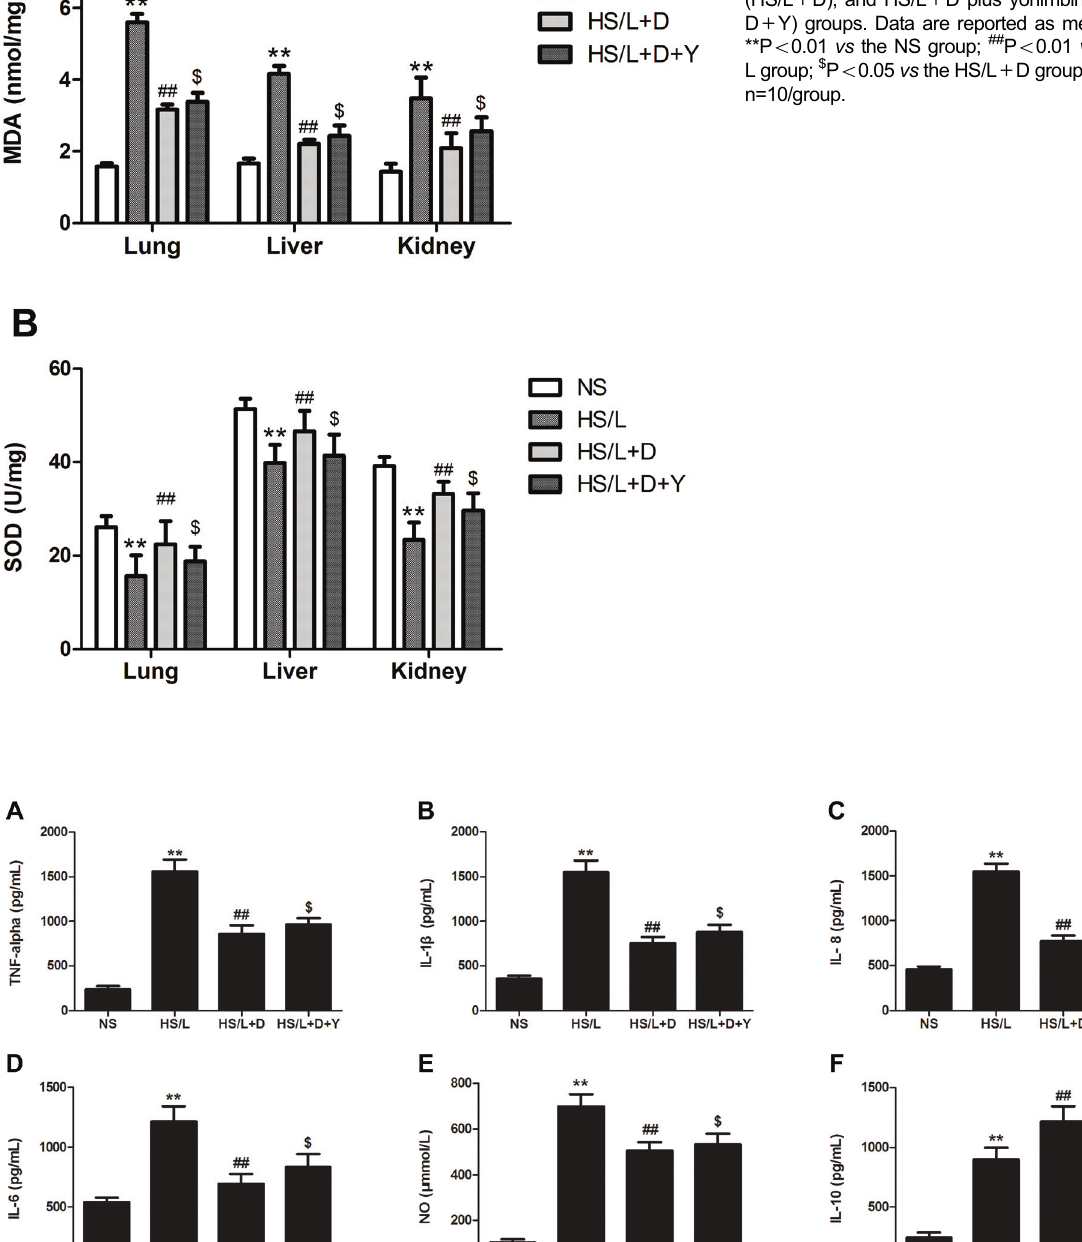
Figure 3. Malondialdehyde (MDA) levels ( A ) and superoxide dismutase (SOD) activity ( B ) in lung, liver, and kidney tissues of the NS control (normal saline), hemorrhage/resuscitation plus lipopoly- saccharide (HS/L), HS/L plus dexmedetomidine (HS/L + D), and HS/L + D plus yohimbine (HS/L + D + Y) groups. Data are reported as means ± SD. **P o 0.01 vs the NS group; ## P o 0.01 vs the HS/ L group; $ P o 0.05 vs the HS/L + D group (ANOVA). n=10/group.